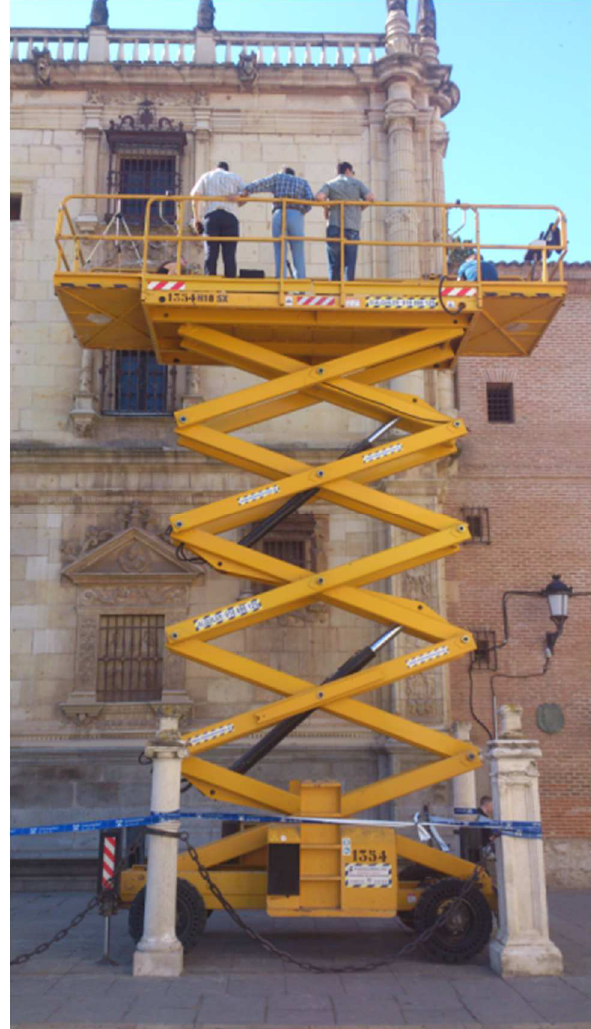
Figure 9: Location of the platform in one of the scan and photographed position .